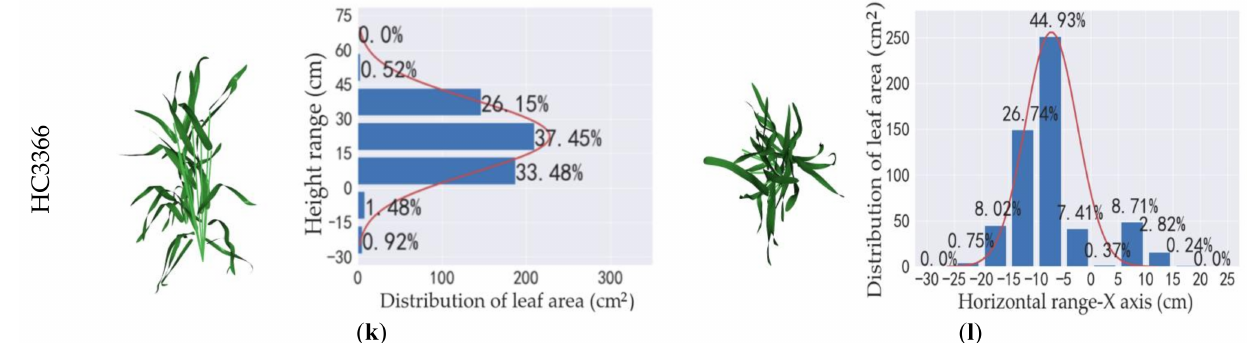
Figure 13. Spatial leaf area distribution of six wheat cultivars. ( a )–( k ) are the vertical leaf area distribution of ZM618, JM106, XN979, JM44, ZXM09, and HC3366, respectively; ( b )–( l ) are the horizontal leaf area distribution of ZM618, JM106, XN979, JM44, ZXM09, and HC3366,